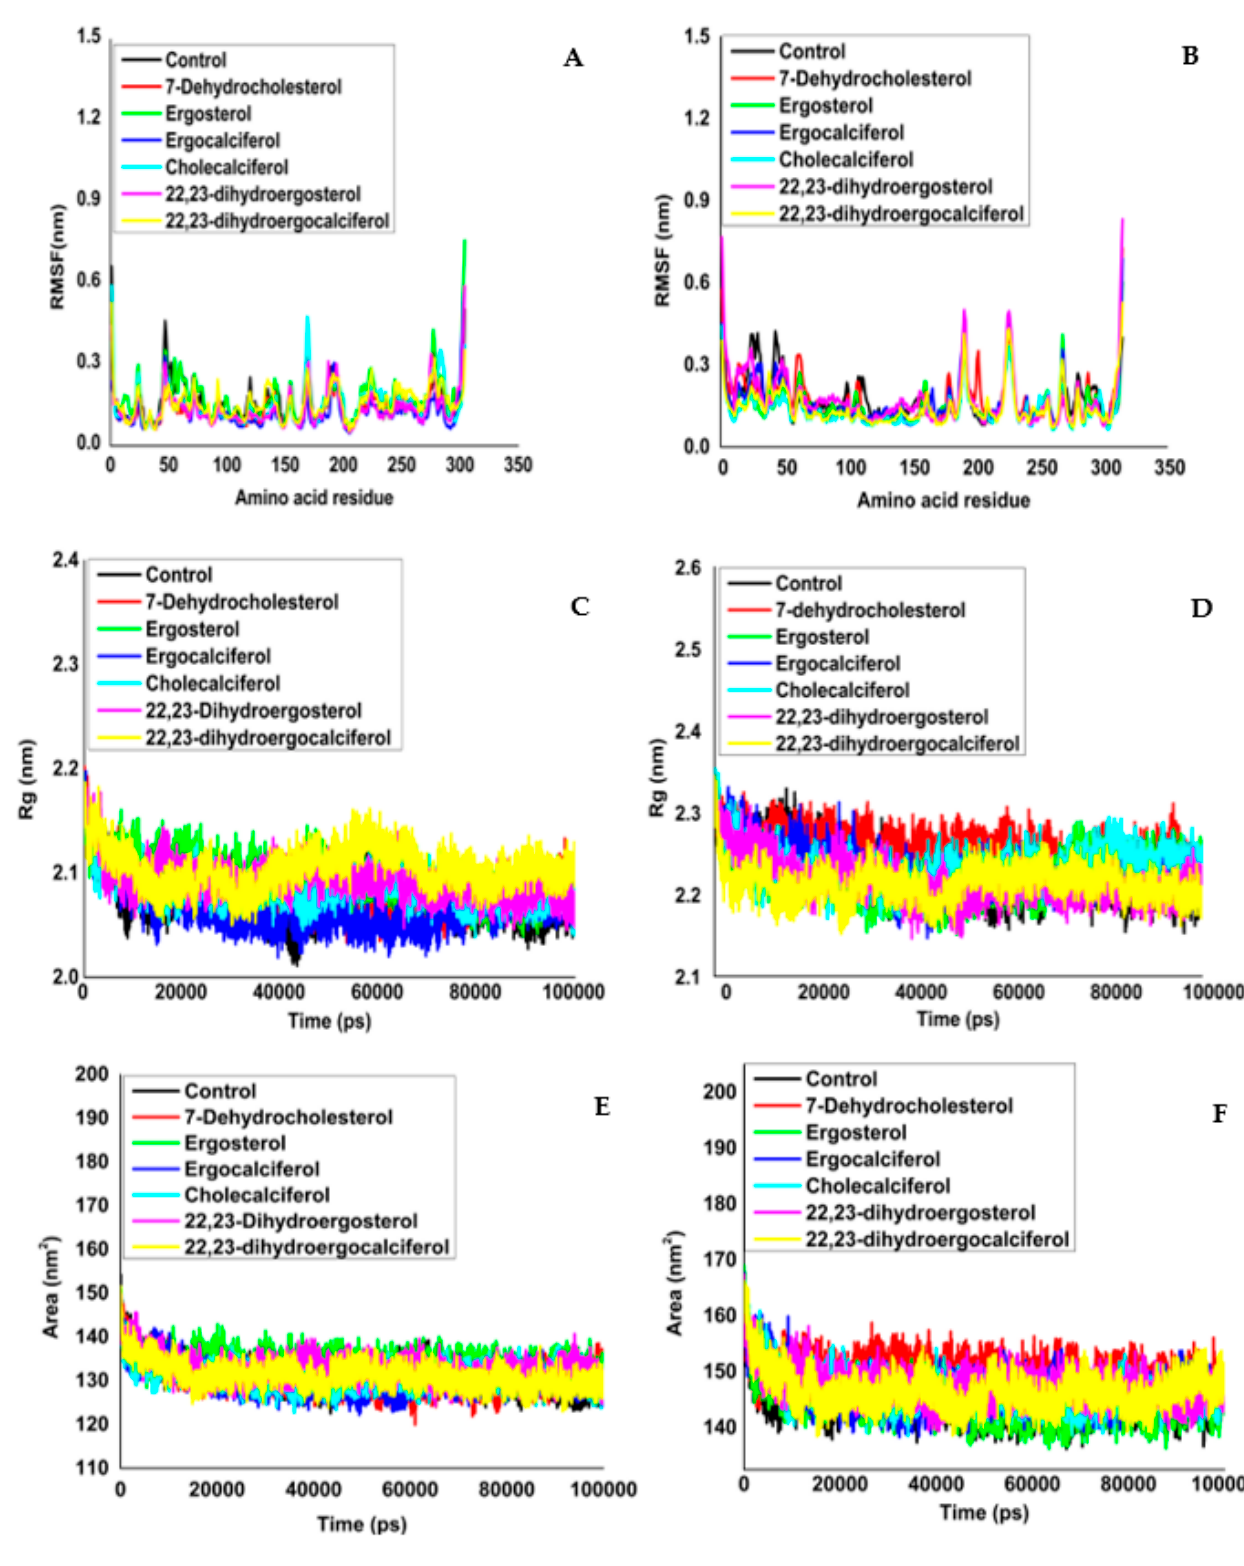
Figure 4. Root-mean-square fluctuations (RMSF) from the initial structures of ( A ) the main protease and main protease–ligand complexes and ( B ) papain-like protease and papain-like protease–ligand complexes during the simulation time. Time evolution plot of Rg for all C α atoms in apo and holo states of ( C ) Mpro and ( D ) PLpro. Solvent accessible surface area (SASA) of ( E ) Mpro and complex and ( F ) PLpro and complex.